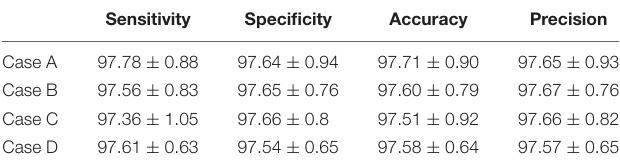
Frontiers in Neuroscience |